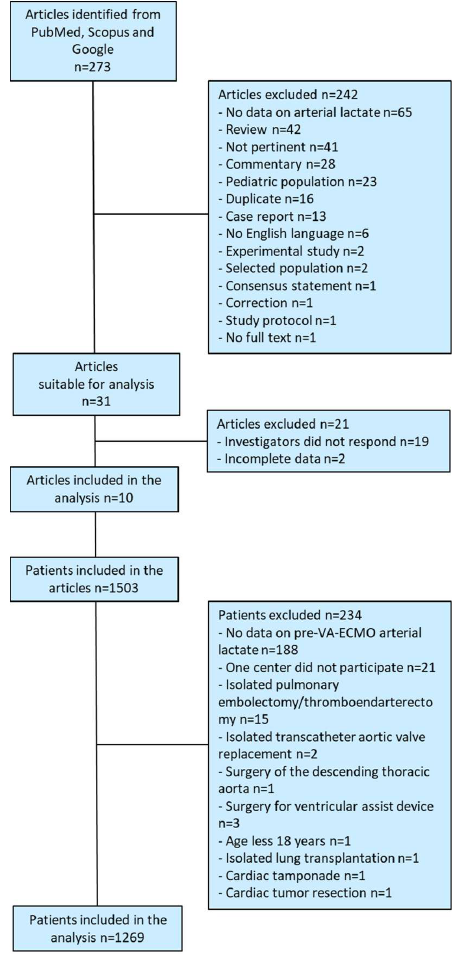
Figure 1. Study flow